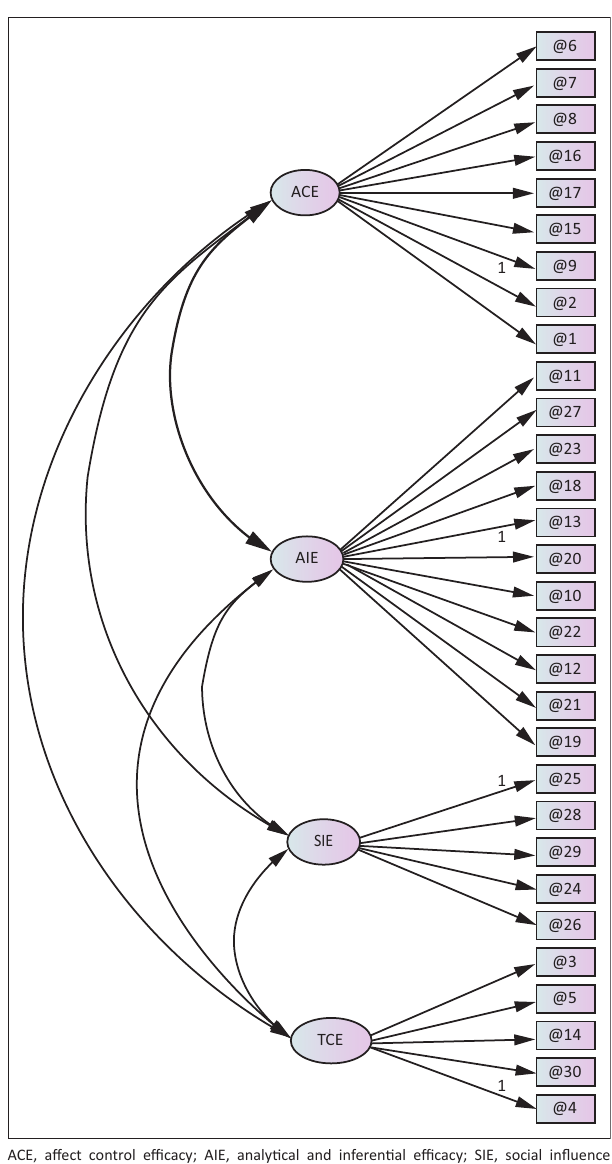
FIGURE 2: Hypothesised confirmatory factor analysis